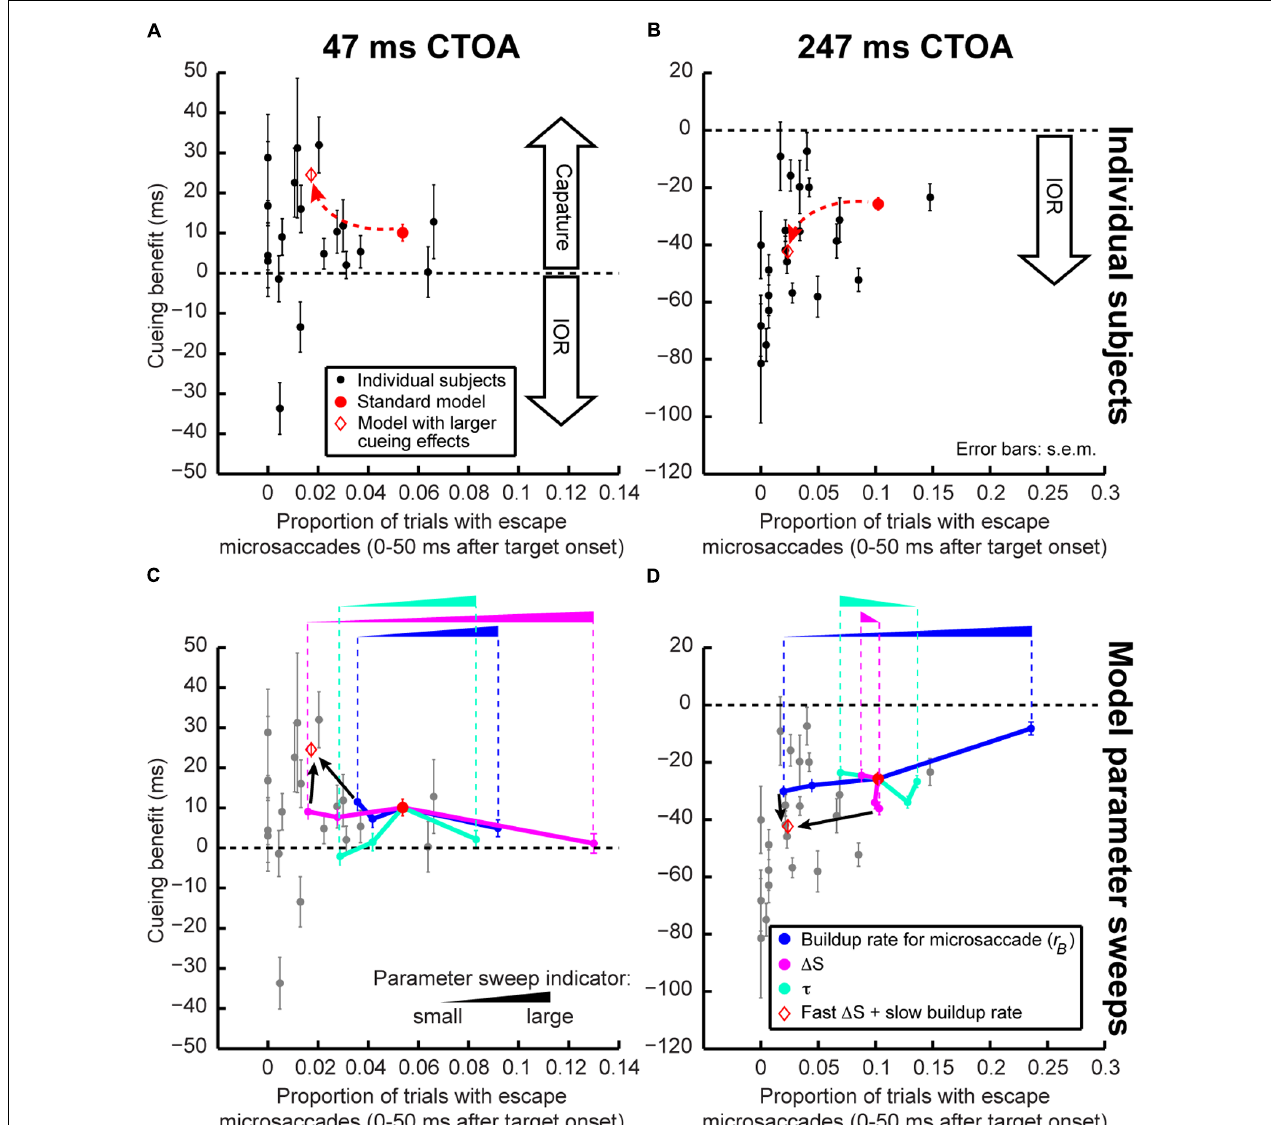
FIGURE 8 | Exploring individual subject variability. (A,B) In each panel, we plotted each subject’s cueing benefit (as defined in Figure 3B ) as a function of his/her proportion of trials with “escape” microsaccades < 50 ms after target onset. Each dot represents a subject, and each panel shows his/her performance at one CTOA. The red circle shows model performance when run as in Section “Results,” and the red diamond shows it when run with fast (cid:49) S ( µ stimulus 1/4 of the standard model) and slow buildup rate ( k m 1/4 of the standard model, see Materials and Methods). Cueing effects were stronger for lower “escape” microsaccade frequency. With simple parameter changes, the model could exhibit similar changes. (C,D) Model parameter sweeps allowing us to explore model robustness. Starting from the standard model (red circle), we changed one parameter at a time while holding all other parameters constant. We changed the dominant buildup rate ( k m , blue), the dominant (cid:49) S processing delay ( µ stimulus , magenta), or the countermanding time constant ( τ , cyan). Model performance moved in systematic ways as parameters changed (the latter were indicated by the ramp icon where the height of a ramp correlates with the size of the parameter being swept). For short CTOA’s (C) , (cid:49) S was a primary determinant of performance changes. For long CTOA’s (D) , buildup rate played a prominent role. When two parameters were changed at a time (red diamond with the smallest µ stimulus and k m ), the model moved along a non-linear trajectory like our subjects. Error bars denote SEM. The gray dots in (C,D) show individual subject data for easier comparison to the model trajectories. In each parameter set, the model was run for 2,000 trials.